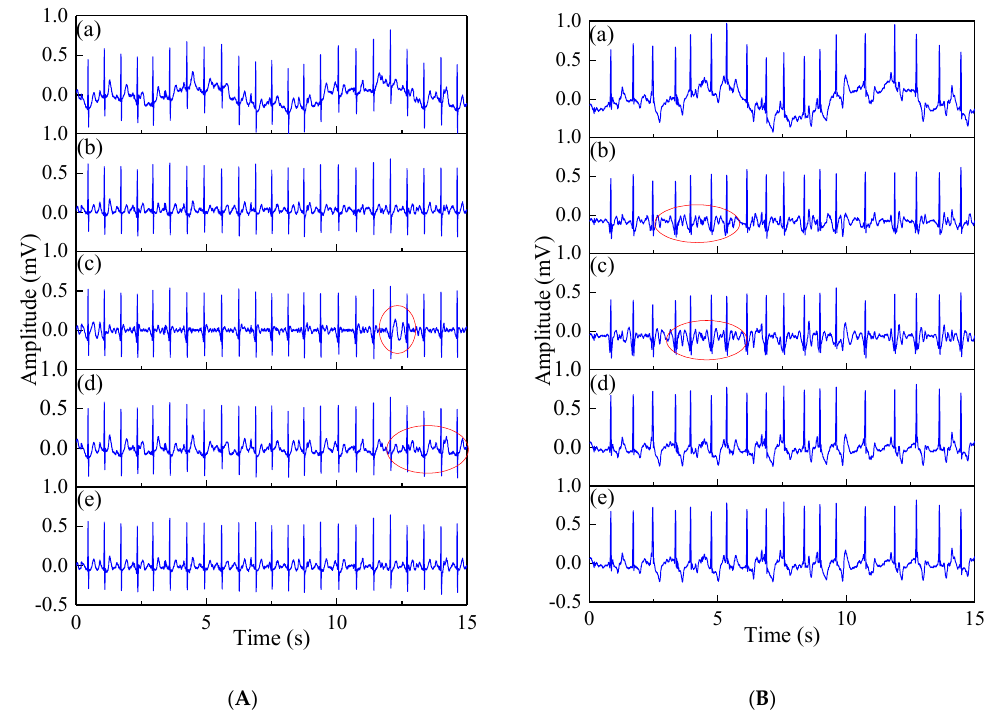
Figure 6. The comparison of the denoising results of different motion artifact removal methods on normal